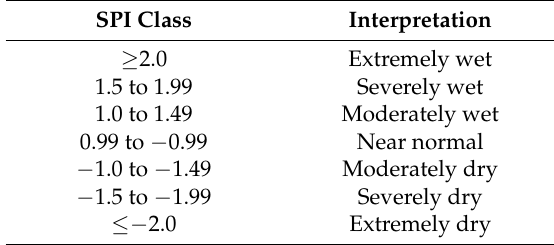
Table 1. SPI class and